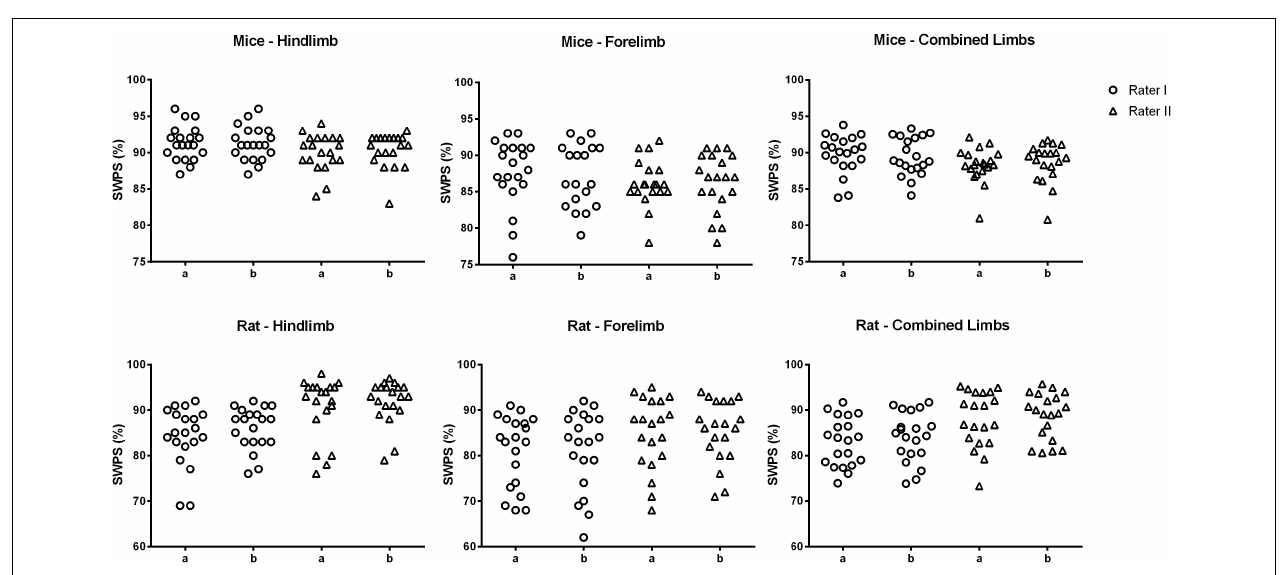
FIGURE 2 | Skilled walking performance score (SWPS)* obtained by raters I and II. The SWPS is represented as a percentage of the maximum possible performance. The number of cycles (NC) each rodent took to cross the ladder is multiplied by 6 (the maximum score for each cycle in the foot fault score system) and the resulting number is considered the maximum possible animal performance (100%). In a trial, each cycle is rated according to the foot fault score system and the sum of the obtained scores provided the total score in the trial (TS). *SWPS = [(TS × 100)/(NC × 6)].